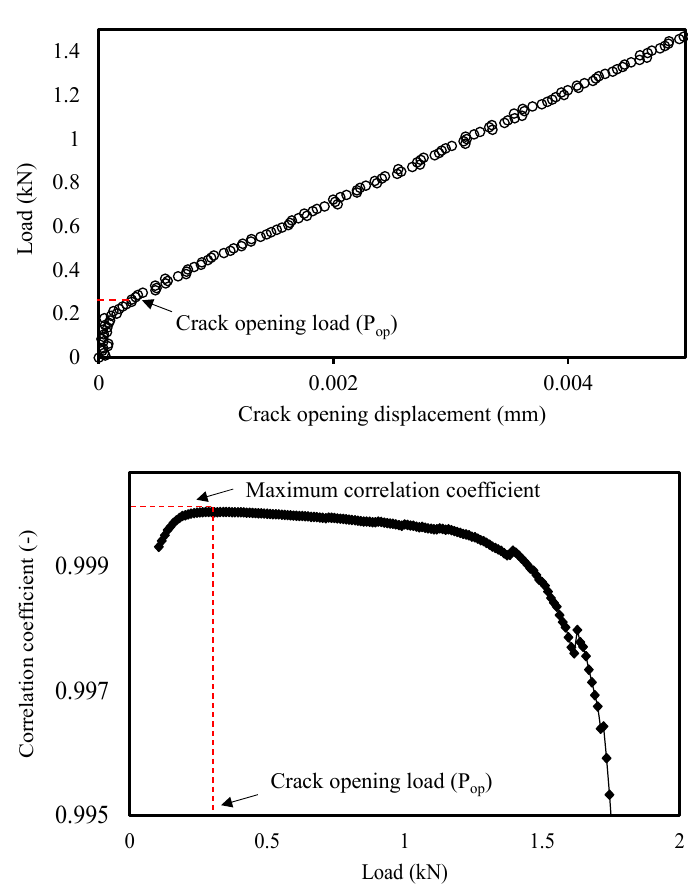
Figure A1. Graphical procedure of the correlation coefficient maximization technique.